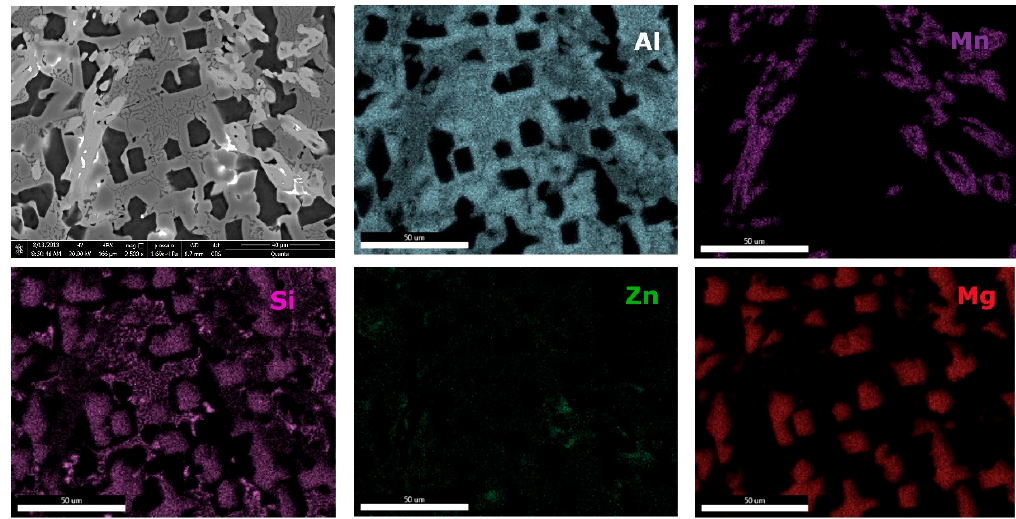
Figure 18. EDS mapping of as-cast Al 3 Mn 0.2 Zn 0.3 Mg 0.7 Si 0.8 alloy.